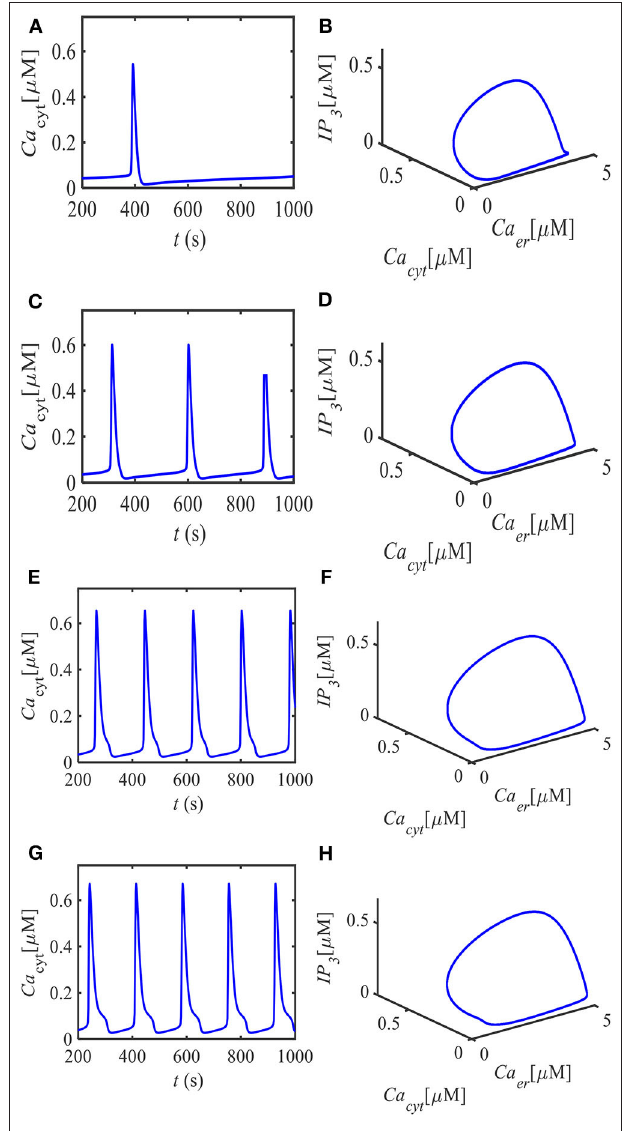
FIGURE 2 | Spontaneous Ca 2 + oscillations in astrocytes emerged at different parts of the curve in Figure 1 relative to points HB1 and HB2. The left panels denote the time evolution of Ca cyt for different sets of parameter v in , and the right panels denote the corresponding Ca cyt - Ca er - IP 3 phase portrait. (A) v in = 0.024 µ M/s, (B) portrait diagram as v in = 0.024 µ M/s, (C) v in = 0.033 µ M/s, (D) portrait diagram as v in = 0.033 µ M/s, (E) v in = 0.052 µ M/s, (F) portrait diagram as v in = 0.052 µ M/s, (G) v in = 0.0593 µ M/s, and (H) portrait diagram as v in = 0.0593 µ